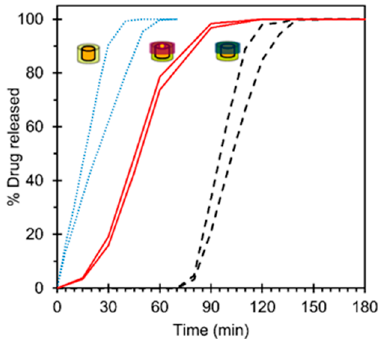
Figure 7. % Drug released vs. time for MV1 (blue), MV2 (black), and MV3 (red). Data is presented as the minimum and maximum of n = 2